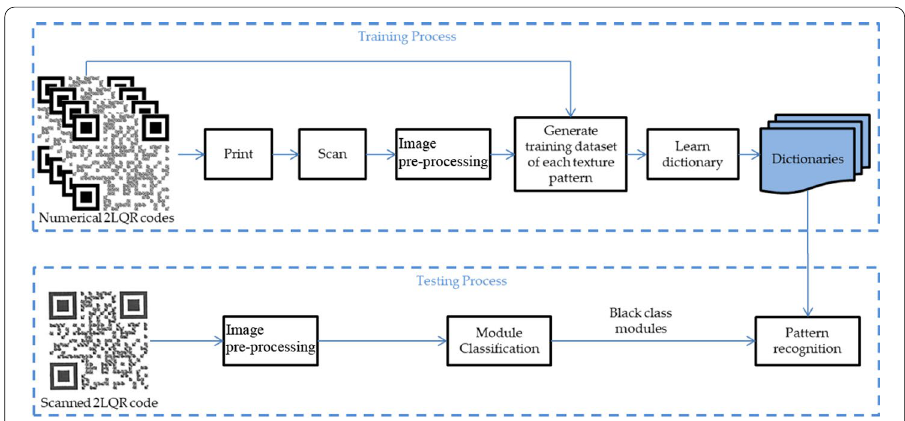
Fig. 8 The whole process of learning dictionaries and pattern